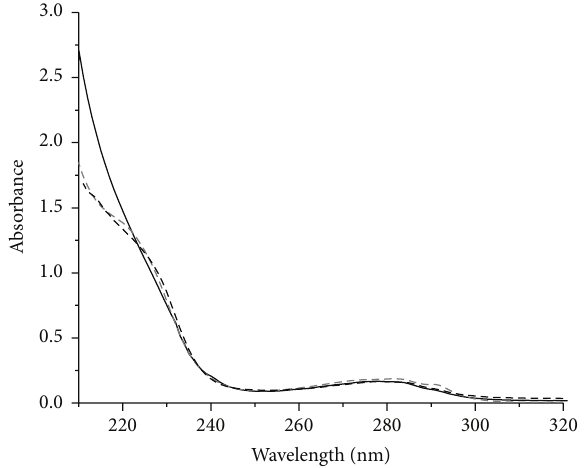
Figure 2: UV spectra of zinc finger proteins. Dark dashed line is ZNF191(243-368), gray dashed line is His 6 -ZNF191(243-368), and dark solid line is ZNF191(243-368)-His 8 .